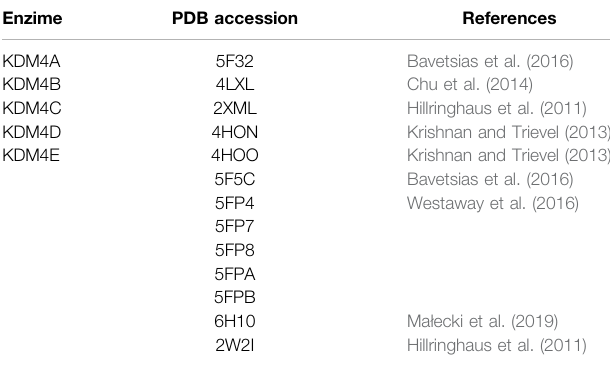
TABLE 1 | Structures used for the molecular docking